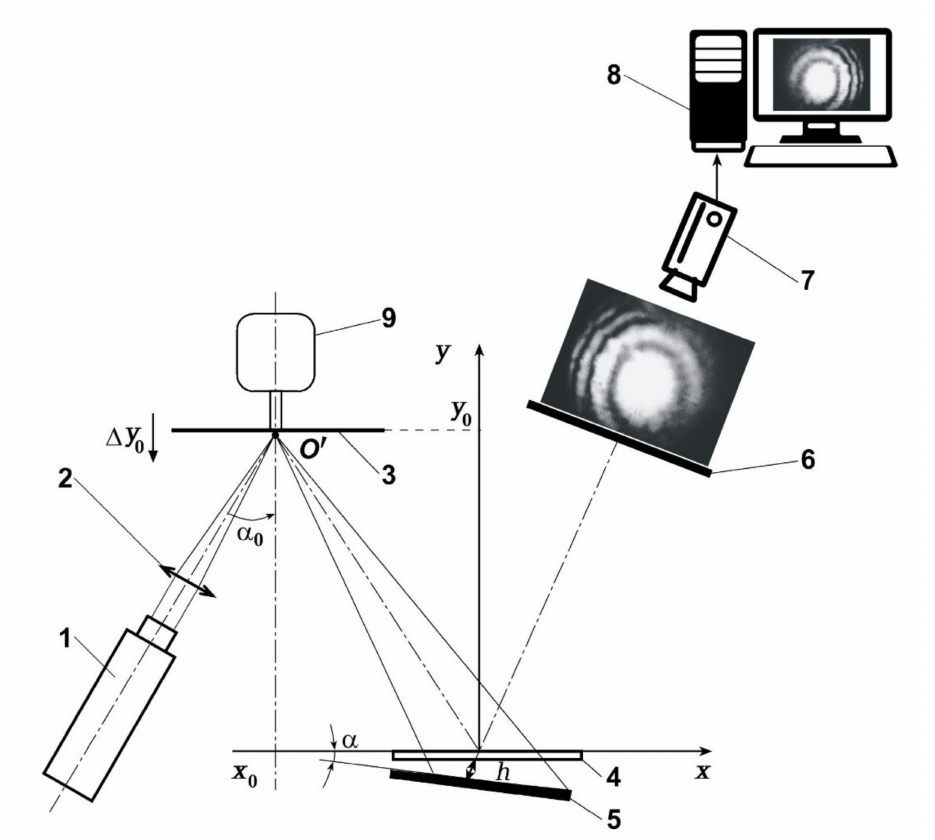
Figure 2. Scheme of experimental